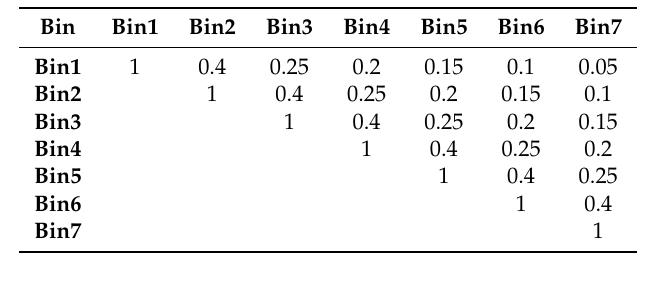
Table 3. Estimated correlation matrix for instantaneous velocity due to turbulence using the recognized pattern of adjacent bins’ correlation of measured